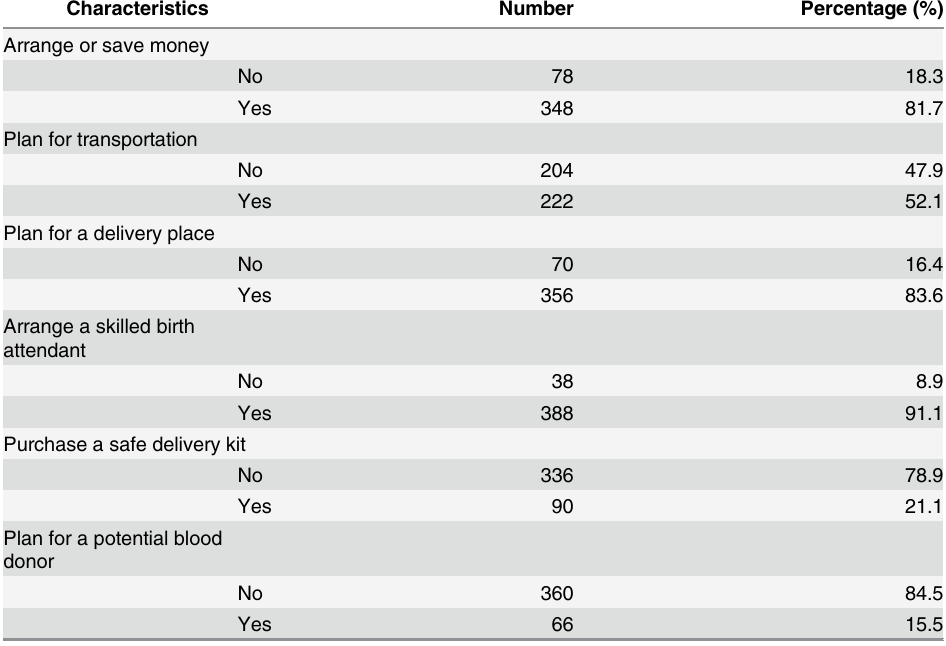
Table 2. Characteristics of Birth Preparedness (n =